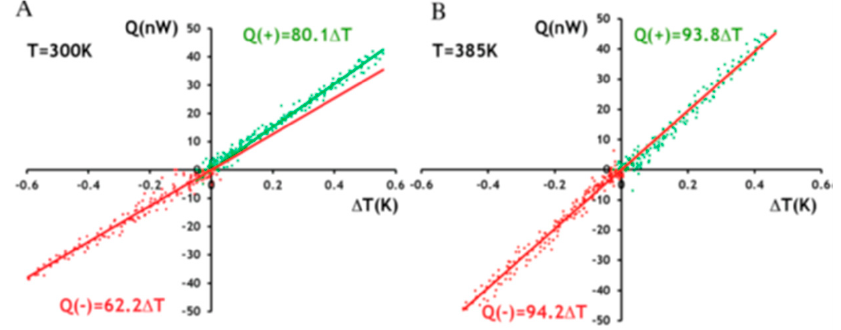
Figure 9. ( A , B ) Heat flow Q as a function of temperature difference Δ T across the VO 2 beams at 300K and 385K, respectively. Different signs (+) and ( − ) of heat flow represent different heat flux directions. Reprinted with permission from ACS Publications.